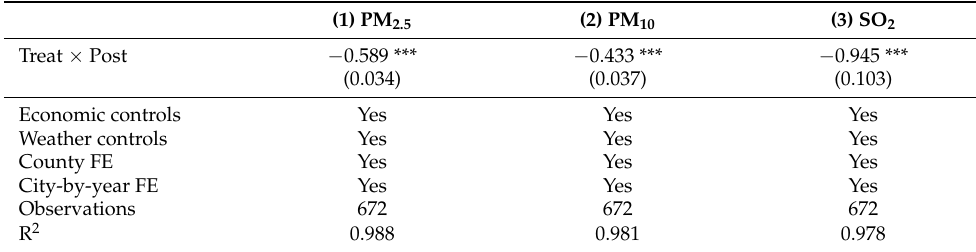
Table 8. Mechanism test: air